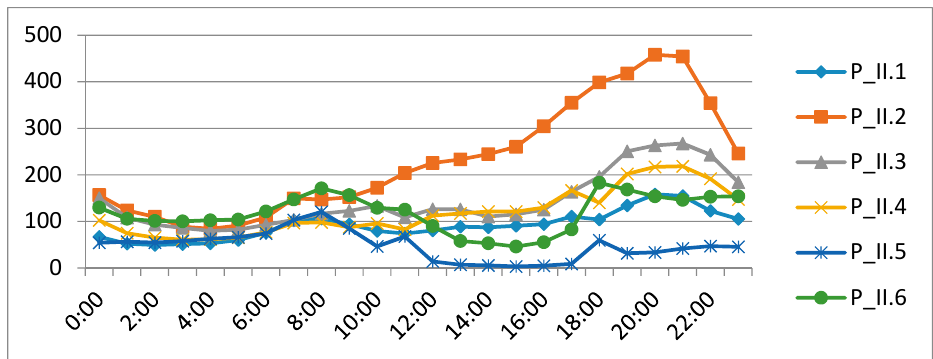
Figure 15. Load profiles obtained with 2 × 2 architecture.